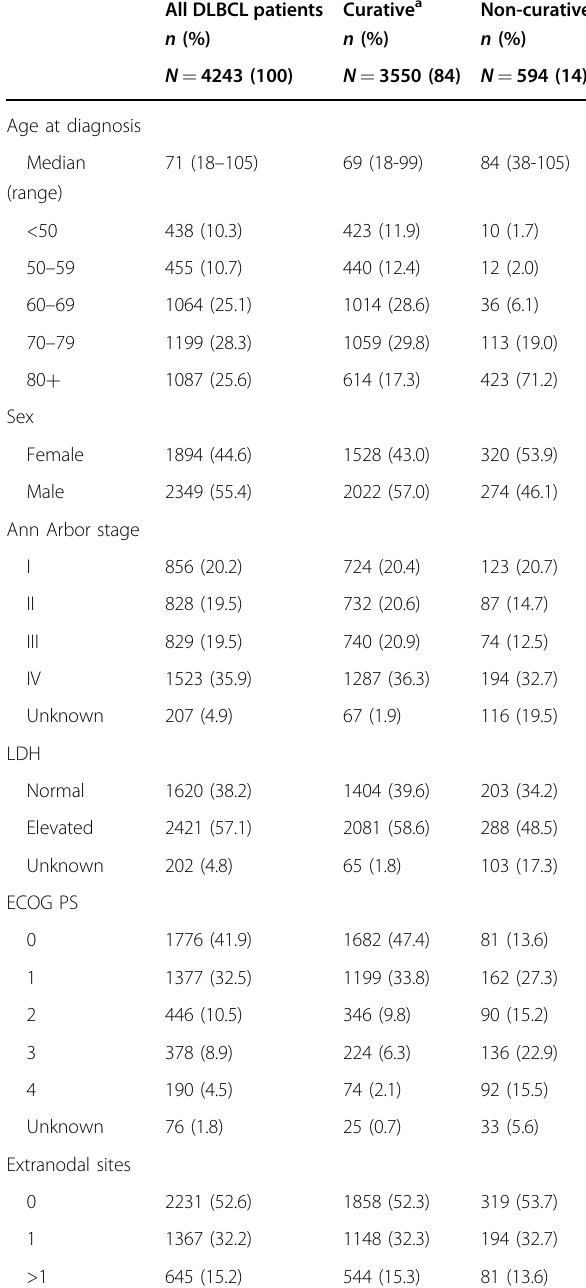
Table 1 Clinical characteristics among all patients diagnosed with diffuse large B-cell lymphoma (DLBCL) 2007 – 2014 in Sweden, and in curatively and non- curatively treated patients separately.